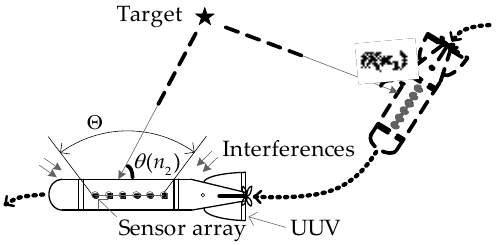
Figure 2. Signal reception diagram for UUV sonar array.